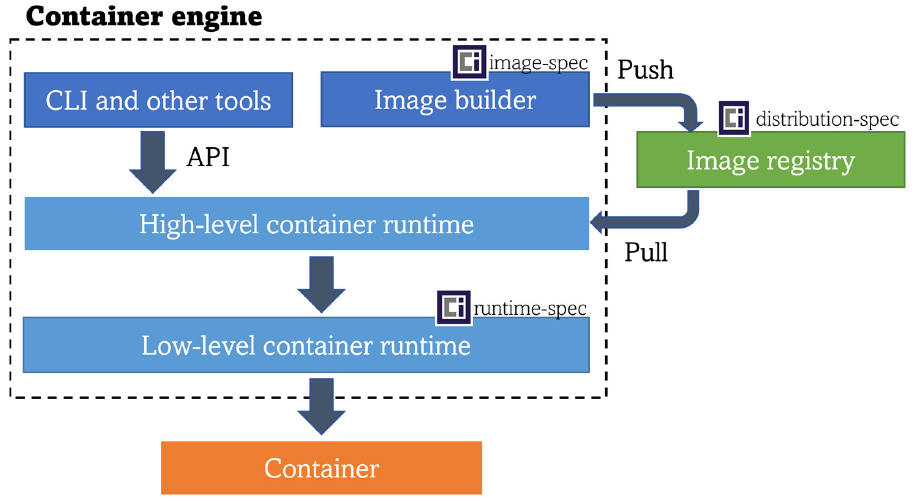
Figure 1. Container workflow block architecture.